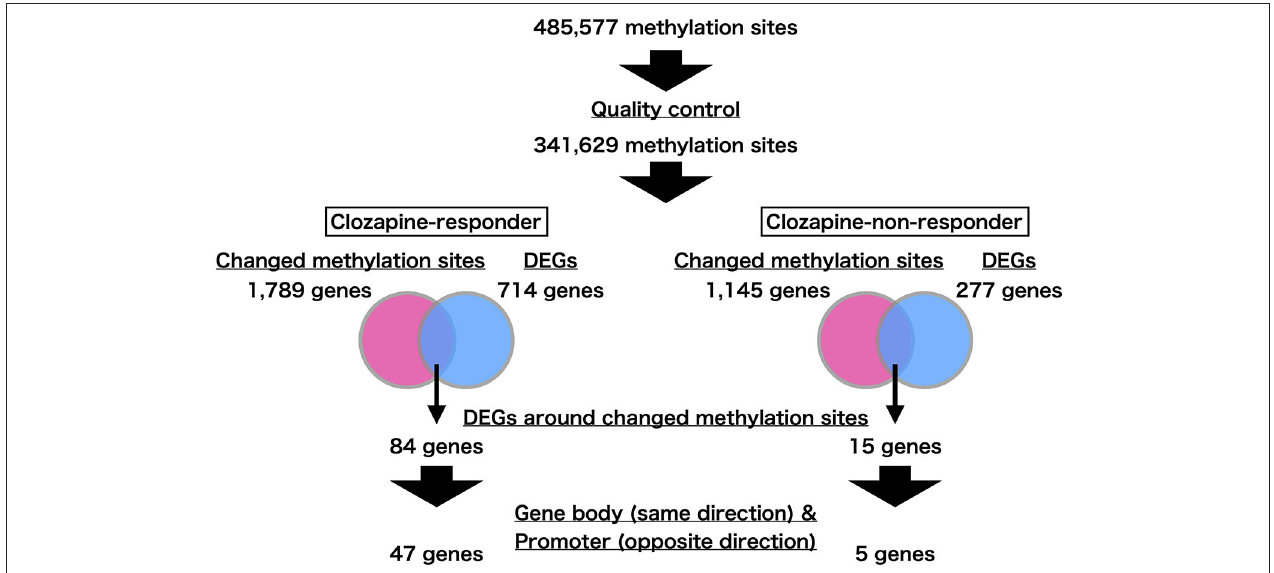
FIGURE 1 | Flowchart of the present study. We first found the genes near the changed methylation sites. We next extracted differentially expressed genes (DEGs) from this set based on transcriptome profiling. Focusing on the methylation sites in gene bodies and promoter regions, we identified genes whose expression changes were consistent with the methylation